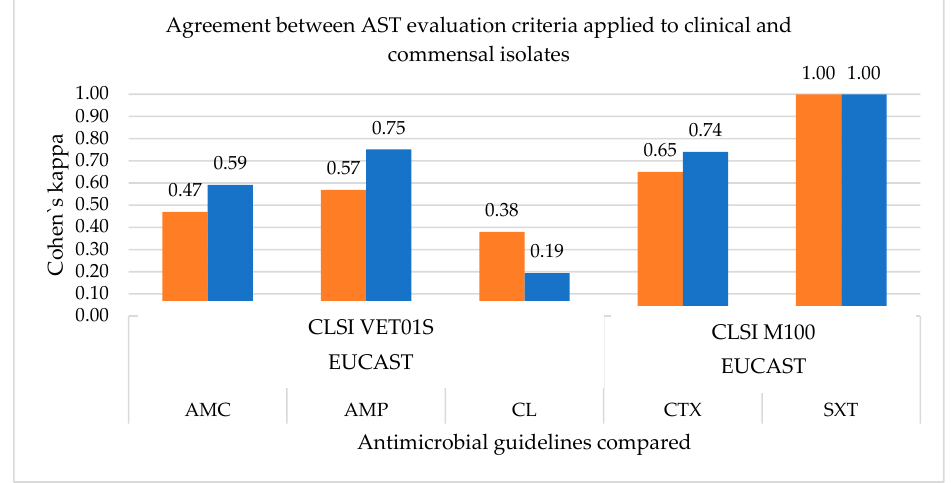
Figure 1. Measurement of the agreement between AST guidelines for the different antimicrobials tested. Cohen’s kappa takes values of (0.1). Clinical strains are represented in orange and commensals in blue.